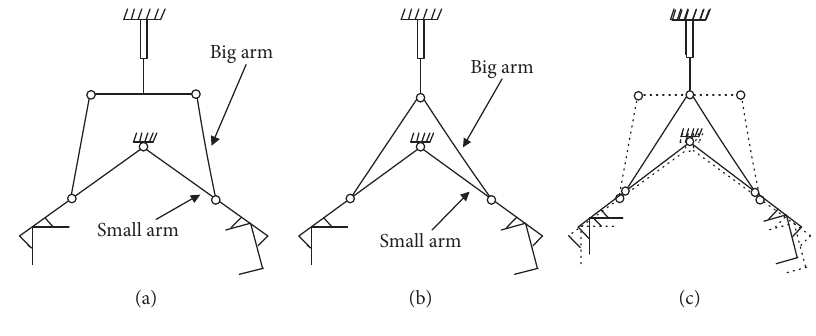
Figure 5: Manipulator configuration.